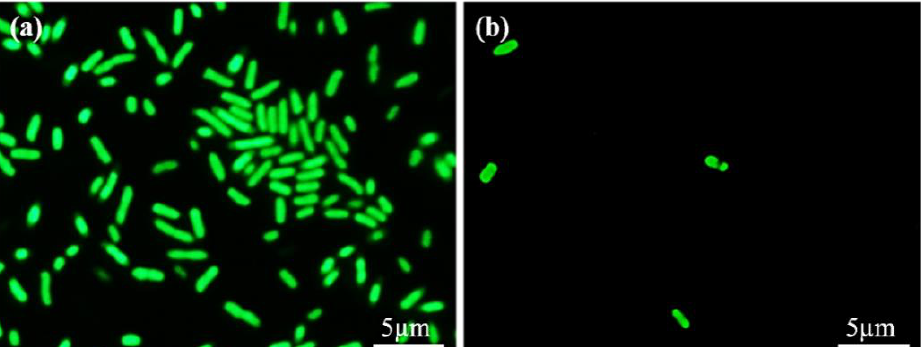
Figure 10. The anti-fouling capability of bacteria ( E. coli ) on the ( a ) pristine PDMS and ( b ) PDMS- PMPC substrate.